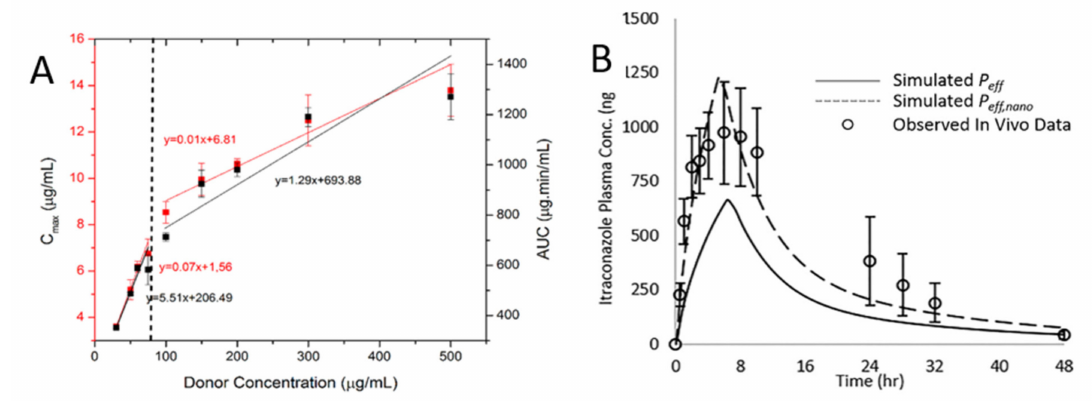
Figure 5. ( A ) The maximum Atazanavir (ATZ) concentration (Cmax) and the area under the curve (AUC) values plotted with respect to the initial donor concentration. The vertical line represents the drug’s amorphous solubility. Reproduced with permission from [111], American Chemical Society, 2018. ( B ) A comparison of the itraconazole in vivo data and permeability models with or without modified with the effect of nanoparticles in aqueous solution “drifting” into the ABL. Reproduced with permission from [139], American Chemical Society,